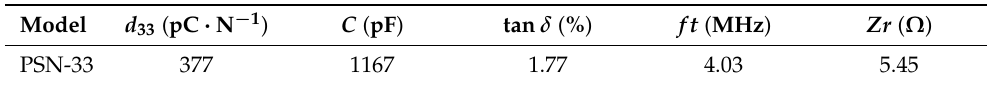
Table 2. The parameters of PZT.